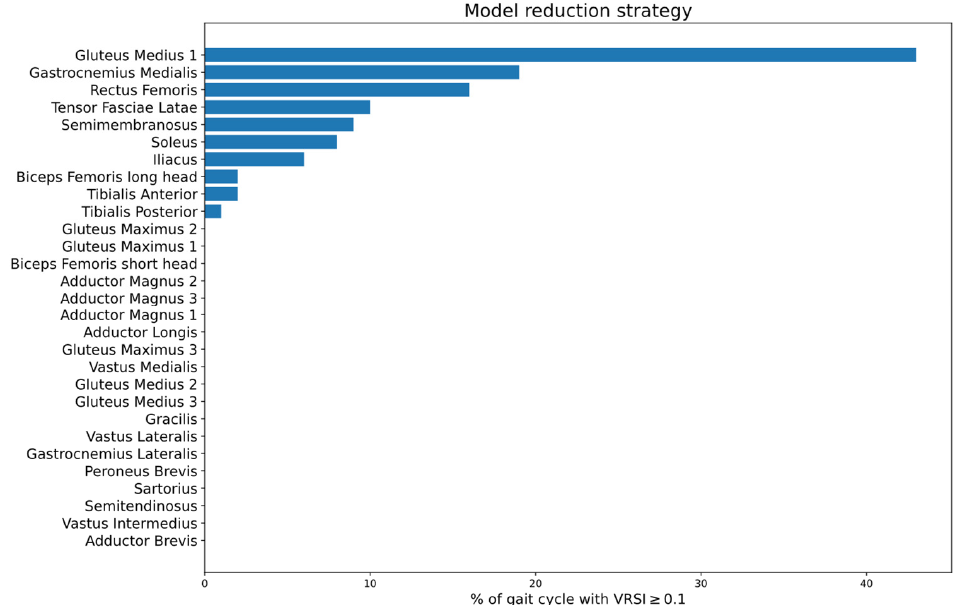
Figure 4. Percentage of gait cycle where VRSI ≥ 0.1 for the muscles included in the analysis. The chosen model reduction strategy prioritises the personalisation of muscles at the top of the plot, where VRSI is above 0.1 for a larger percentage of gait cycle.